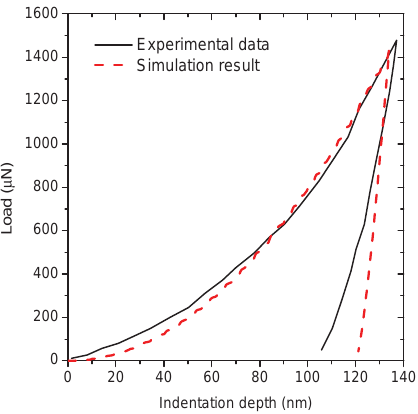
Figure 3. Comparison of numerical and experimental load-depth curves for the α phase layer of the lamellar Ti-5553 alloy.